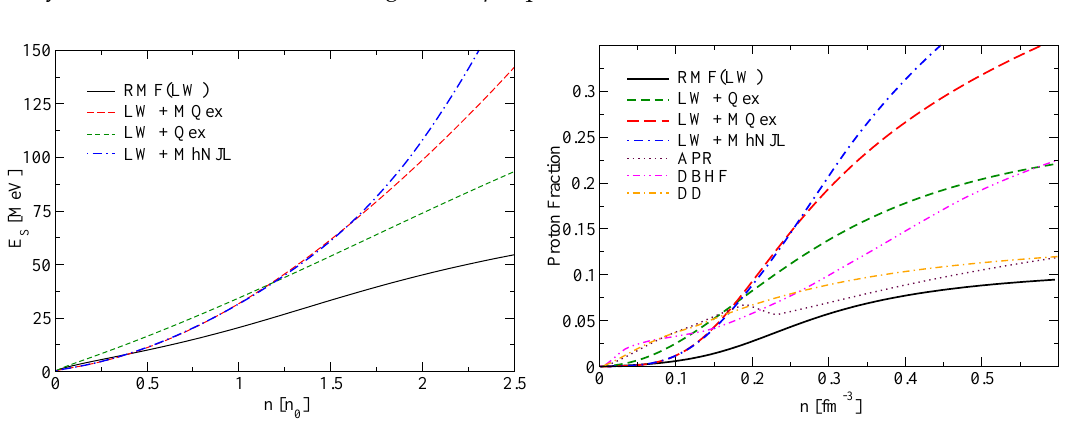
Figure 8. ( Left panel ): Symmetry energy as a function of density for RMF (LW) (solid lines), LW + Qex (dashed lines), LW + MQex (long-dashed lines) and LW + MhNJL models. ( Right panel ): Proton fraction as a function of density for these models (same line styles) in comparison to standard neutron star EoS: APR, DBHF and the DD RMF